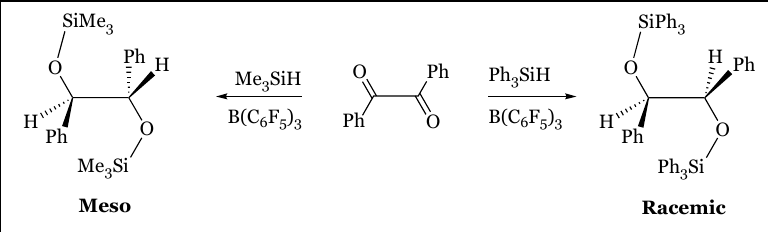
Figure 32. Stereoselectivity of α -diketone silylation product based on silane.